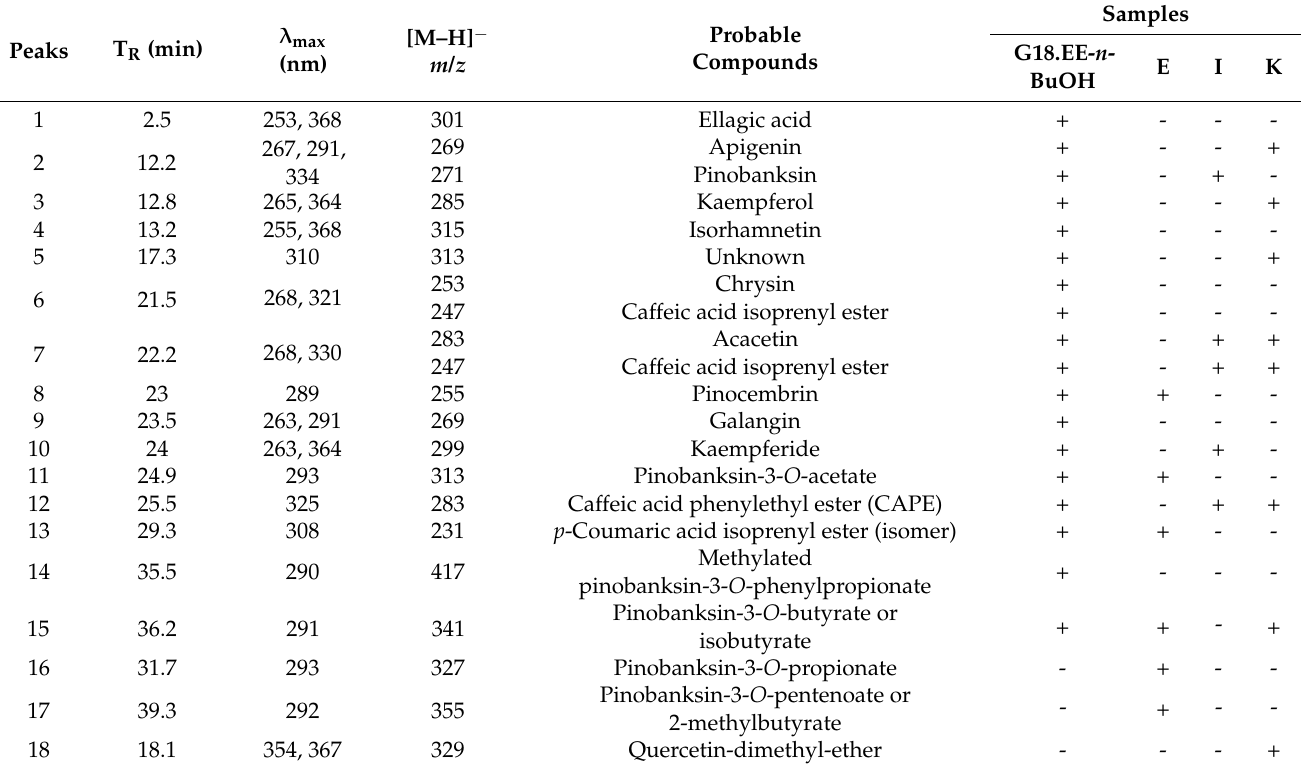
Table 2. Chemical composition of G18.EE- n -BuOH and subfractions E, I, and K according to UHPLC- DAD-ESI-MS n